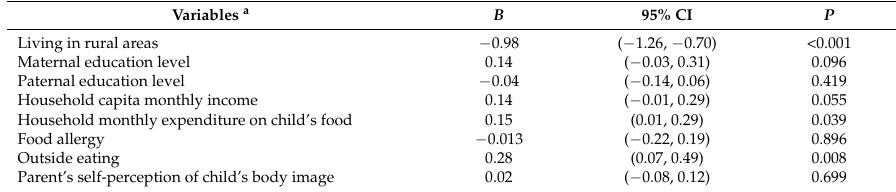
Table 4. Linear regression model on predictors of DDS 10 among Chinese preschool children ( N = 697). Variables